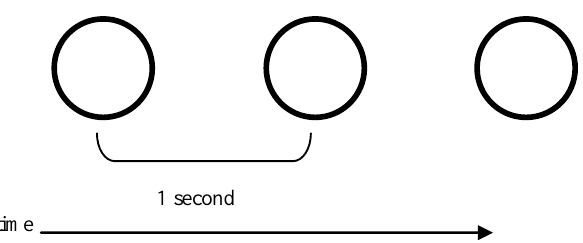
Figure 8. Separated frames from immersive videography.